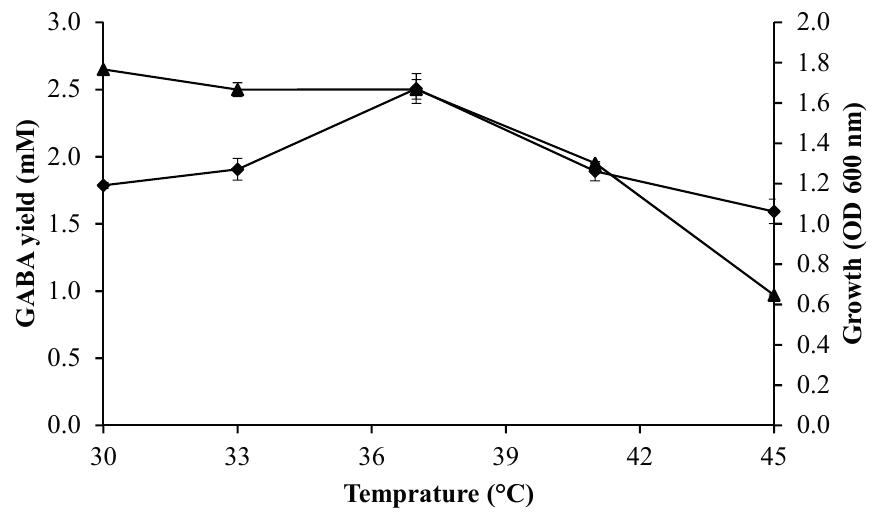
Figure 3. Effect of temperature on growth profile and GABA production by Lactobacillus plantarum Taj-Apis362. Culture conditions were fixed as follows: initial glutamic acid concentration, 50 mM; initial pH, 5; and incubation time, 60 h. Symbols: ( ▲ ) growth; ( ♦ ) GABA. The vertical bars represent the standard deviations (SD) from 3